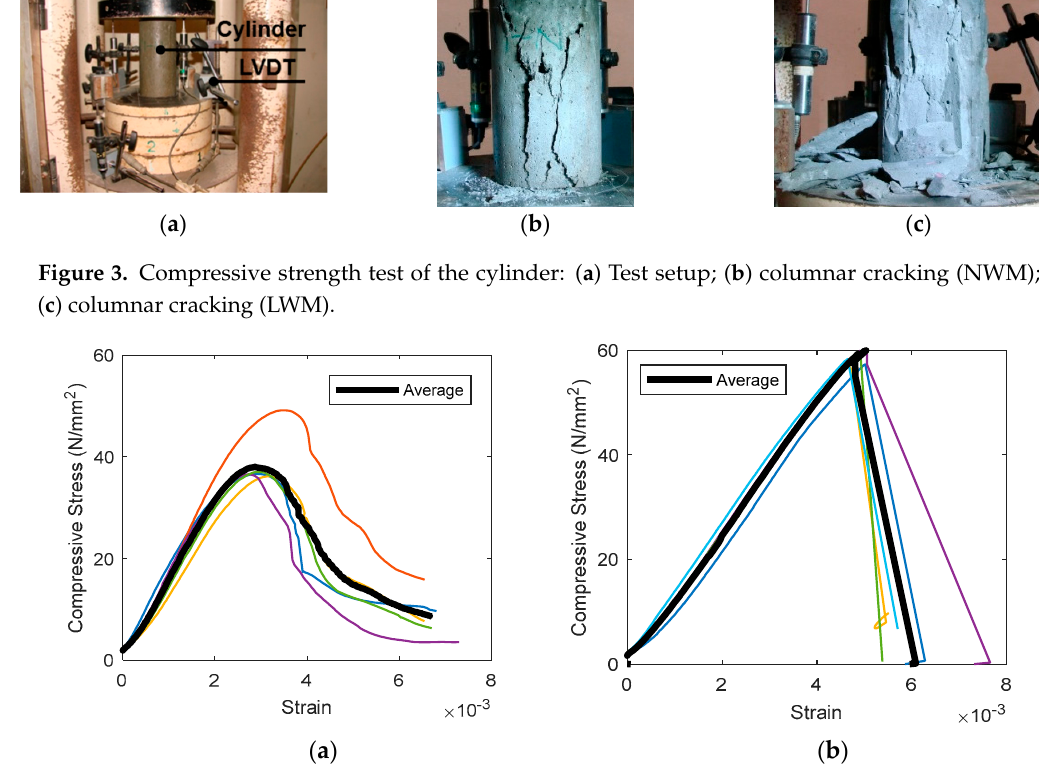
Figure 4. Stress–strain curves of the cylinders: ( a ) cylinders with NWM; ( b ) cylinders with LWM.